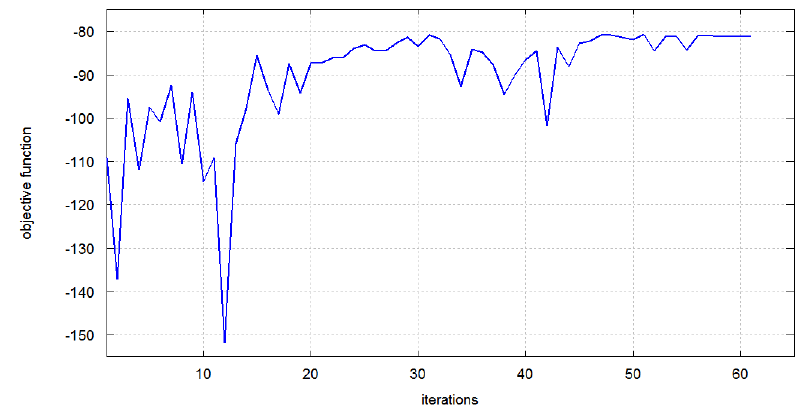
Figure 8. Optimization process with the three-antenna scenario; the objective function is the minimum of S 21 and S 31 .